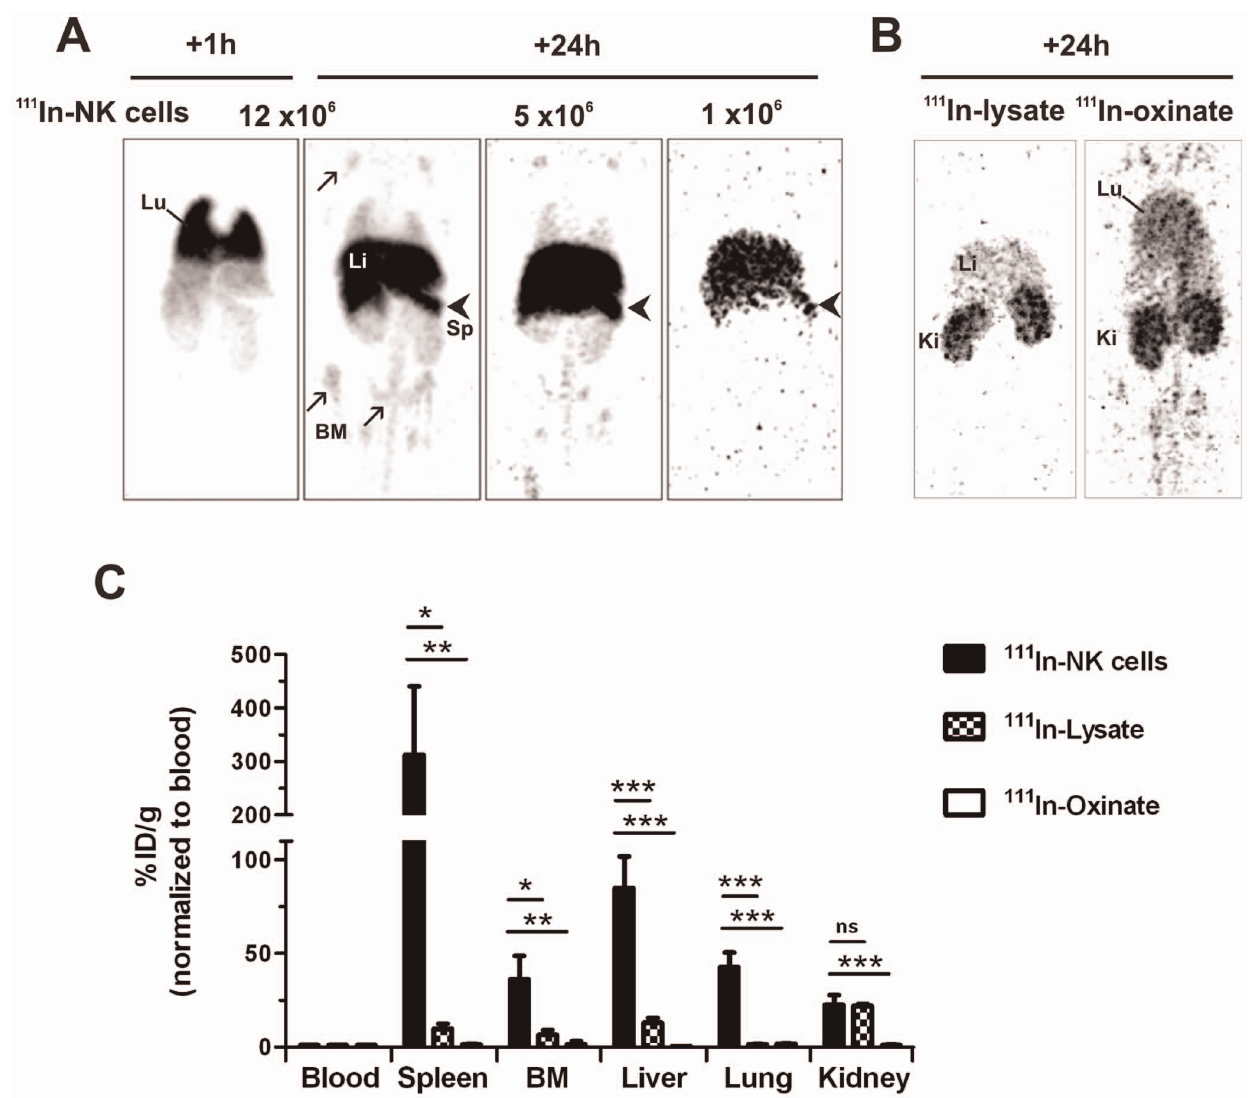
Figure 2. SPECT-CT imaging provides good sensitivity and specificity to track 111 In-labeled UCB-NK cells invivo . To address the feasibility of UCB-NK cell tracking in vivo , adult NSG mice were injected i.v. either with increasing doses of 111 In-NK cells (1, 5 or 12 6 10 6 111 In-NK cells per mouse equivalent to 1, 5 and 12 MBq respectively, n=5 in total), with a lysate obtained from 111 In-NK cells ( 111 In-lysate, n=2) or with 111 In- oxinate (n=3). (A) Representative whole body SPECT scans acquired 1 h and 24 h after injection of 111 In-NK cells with major visualization of lungs (Lu), liver (Li), spleen (Sp, arrowhead) and bone marrow (BM, arrow). (B) Representative whole body SPECT scans acquired 24 h after injection of 111 In- NK cell lysate or 111 In-oxinate; kidneys (Ki), heart (He). (C) Quantitative biodistribution analysis performed 24 h after injection. For comparison, the relative 111 In-content of each tissue of interest was normalized to blood. Data are shown as mean 6 SD. * p , 0.05, ** p , 0.01, *** p , 0.001.